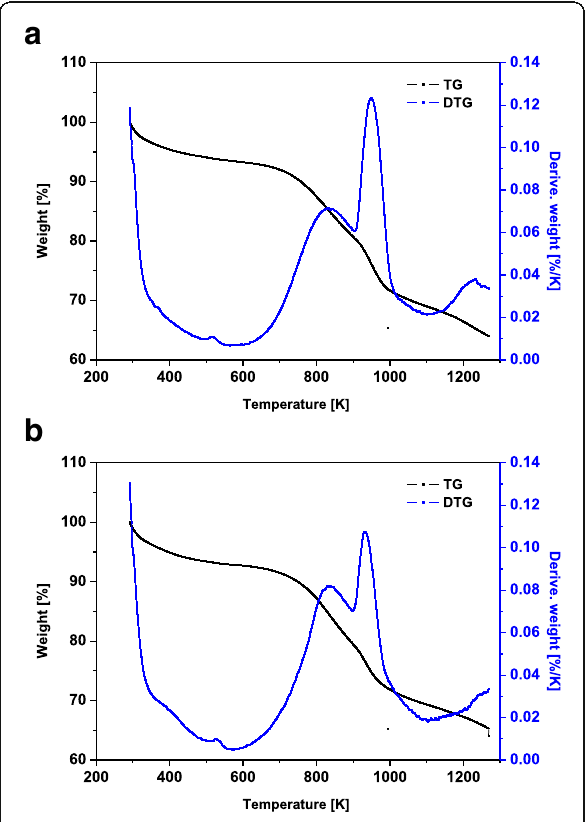
Fig. 9 TG/DTG curves of a MBC1 and b